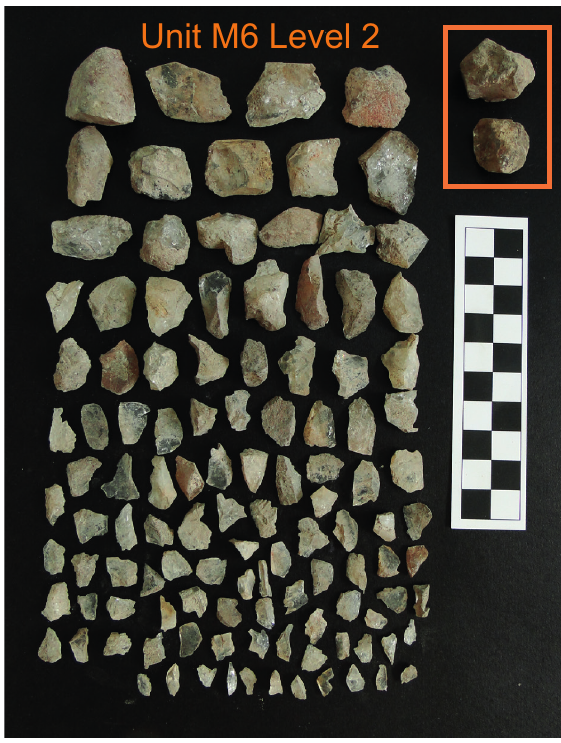
Figure 12 - Sample of cores (inside box) and flakes from Unit M6, Level 2, later than 4200 cal